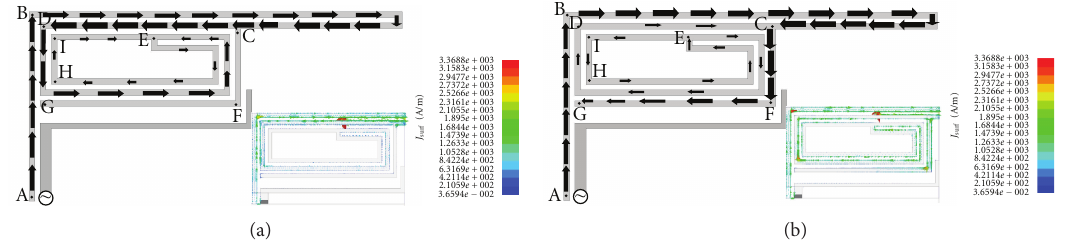
Figure 3: Current distributions at (a) 0.752 GHz and (b) 0.776 GHz.